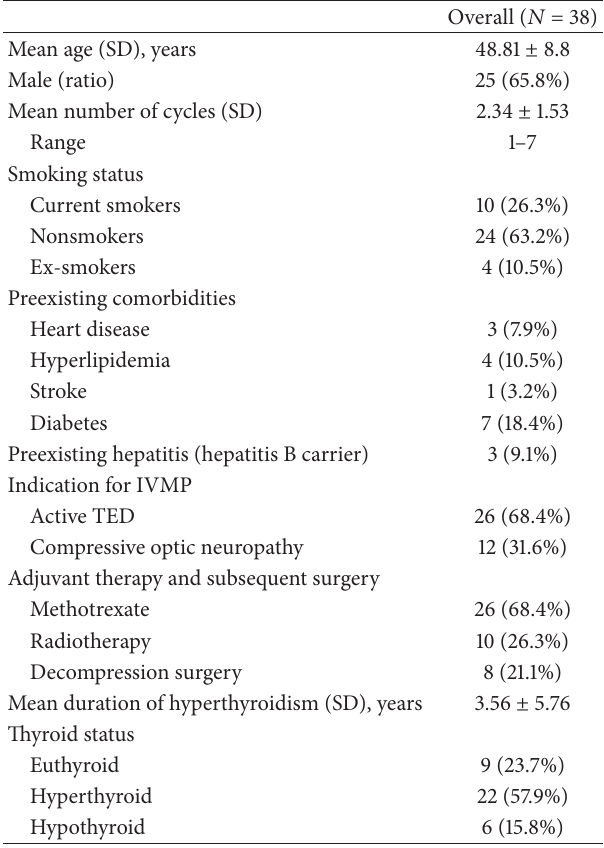
Table 1: Characteristics of study